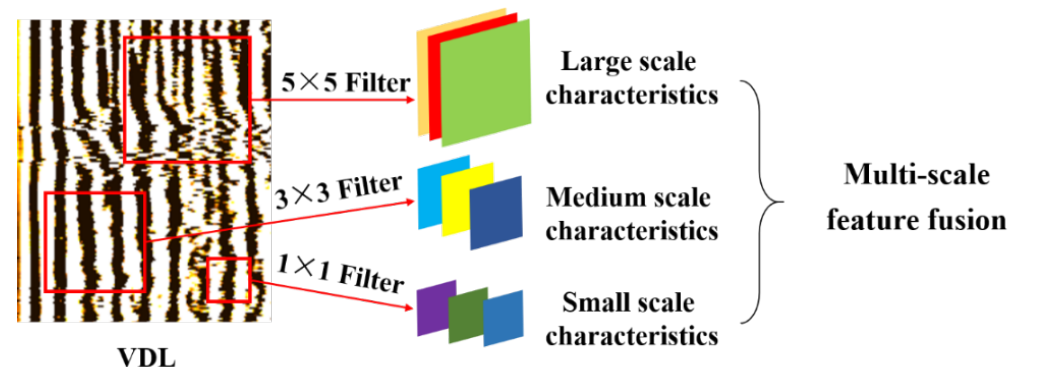
Figure 8. Image feature extraction with multiple parallel filters of different sizes.